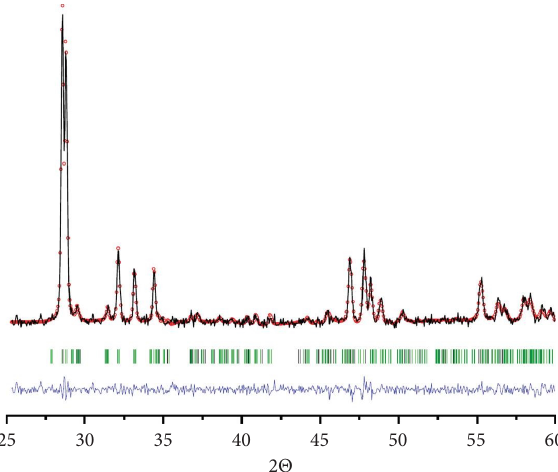
Figure 2: Experimental (red dots) and calculated (black profle) XRD patterns, their diference (blue profle), and Bragg refection positions (green lines) of Tb 5 Mo 3 O 16+ δ .